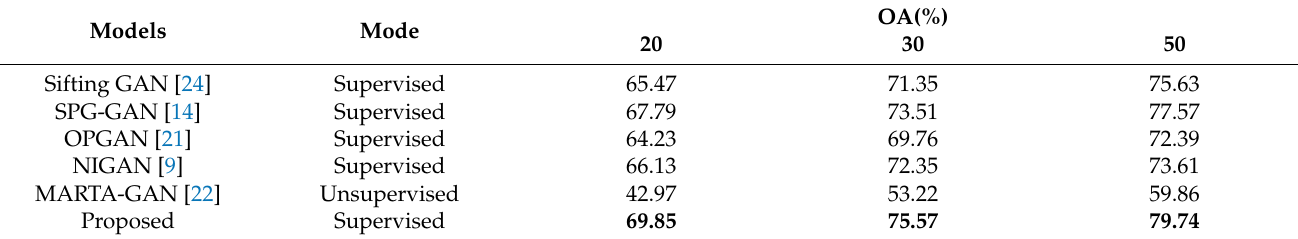
Table 3. Classification accuracy on the UC Merced